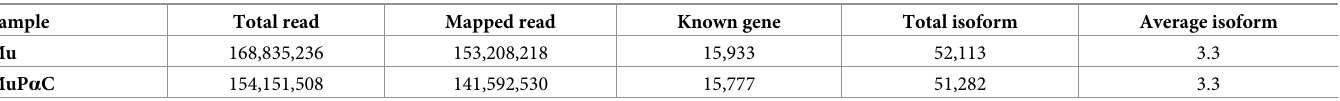
Table 1. Summary of transcriptomes obtained from colonic mucosal tissue (Mu) and subepithelial PDGFR α + cells (MuP α C).